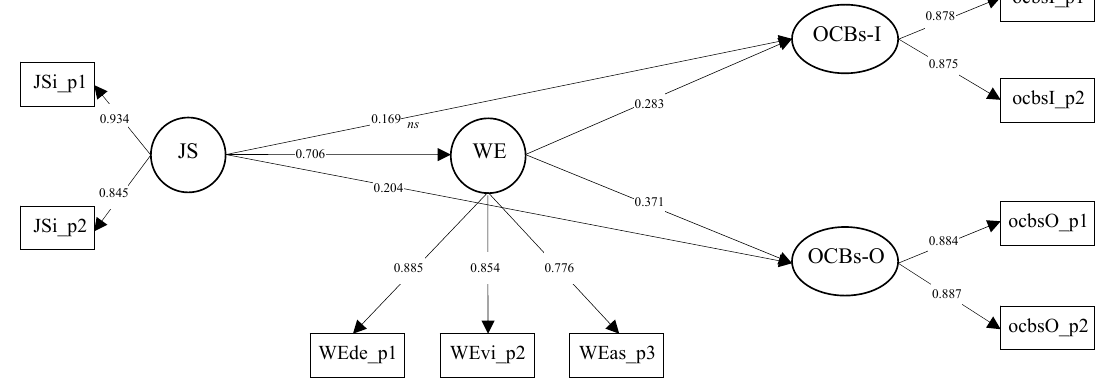
Figure 2. The partial mediational model with standardized coe ffi cients. Note: Jsi_p1 = Parcel 1 of JS; Jsi_p2 = Parcel 2 of JS; JS = job satisfaction; Wede_P1 = Parcel 1 of WE (dedication); Wevi_P2